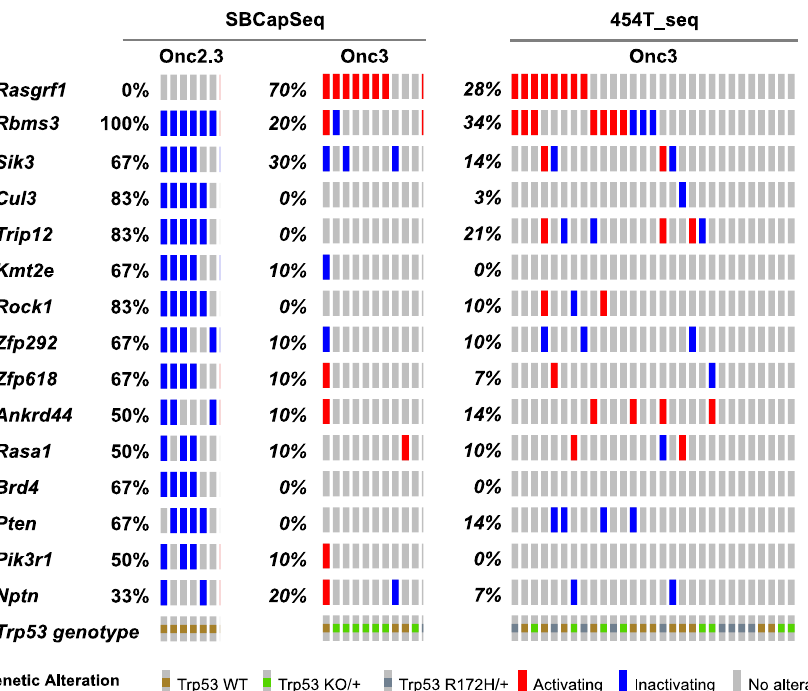
Figure 3. SB-driven lung cancer by cumulative tumor suppression. Recurrent inactivating SB insertions in Onc2.3 (n = 6 using SBCapSeq) and Onc3 (n = 10 using SBCapSeq; n = 29 using 454T sequencing) induced LUAA genomes.